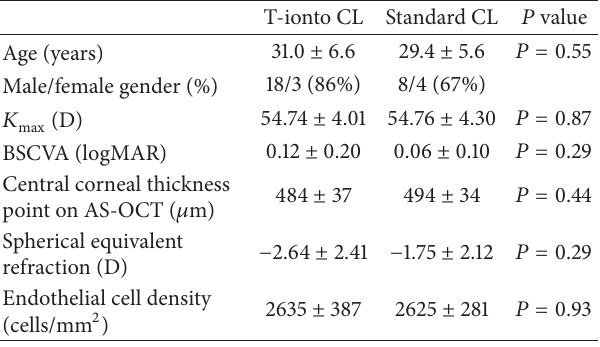
Table 1: Baseline demographics and clinical characteristics of eyes in the study (T-ionto CL) and control (standard CL) groups (M ±